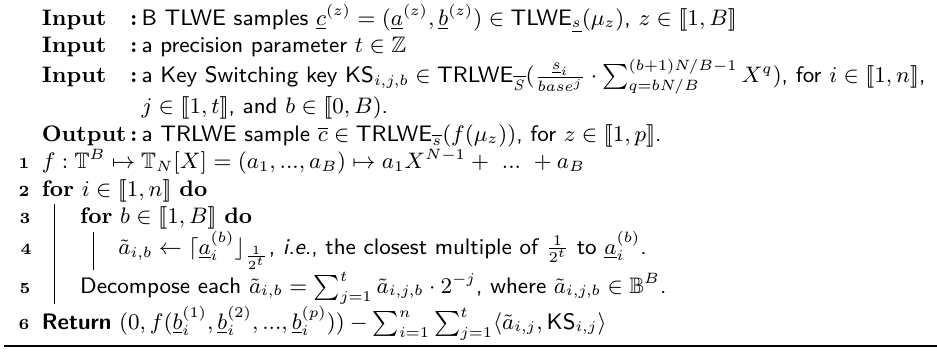
Algorithm 7: Base-aware TLWE-to-TRLWE Public Functional Key Switching